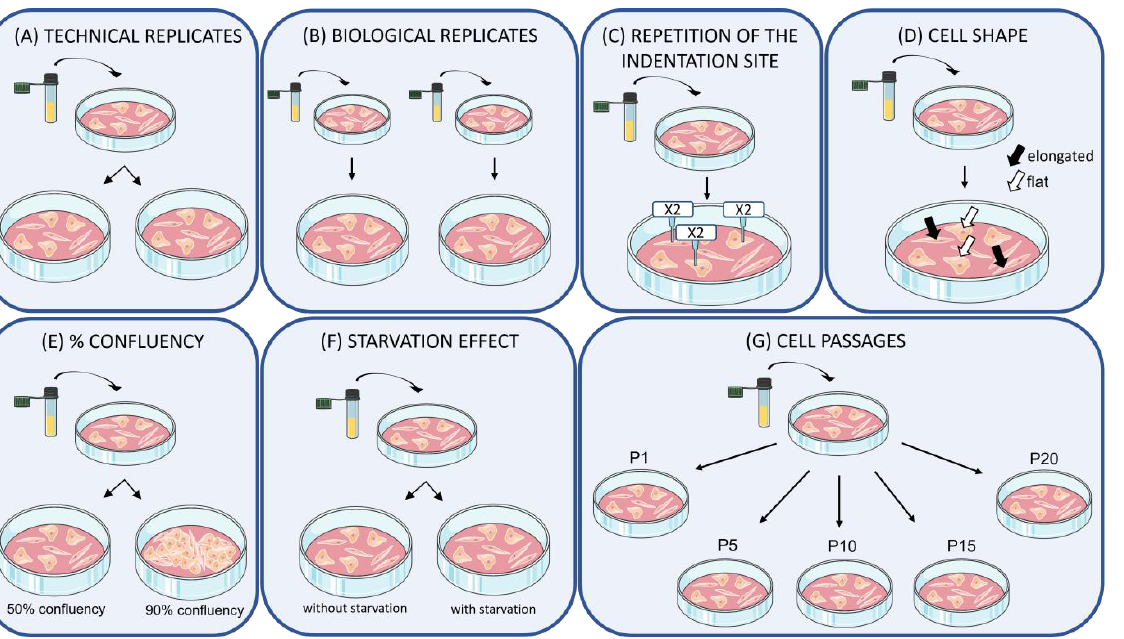
Figure 1. Assessment of cell elasticity values under different conditions and experimental designs. Cell elasticity values have been compared under different experimental conditions, sketched in Figure 1: (A,B) the comparison of elasticity data obtained over technical rep- licates, as well as those retrieved from biological replicates; (C) the maintenance of stiff- ness values when indentation occurs repeatedly in the same indentation cell site; (D) the evaluation of stiffness obtained from indenting cells showing different shapes; (E) the measure of elasticity of cells at different levels of cell confluence; (F) the evaluation of stiffness values in cells with or without starvation; (G) possible changes in elasticity during cell aging (considered as cell passages). These conditions are often considered in experimental design, and as critical features for stiffness measurement, could influence the robustness of the retrieved elasticity data. To test this hypothesis, identical cell cul- ture steps (see Section 2.2), acquisition modes, and data analyses (see Section 2.3) were carried out, while enabling the listed conditions, to verify the steadiness and reproduci- bility of cell elasticity results.